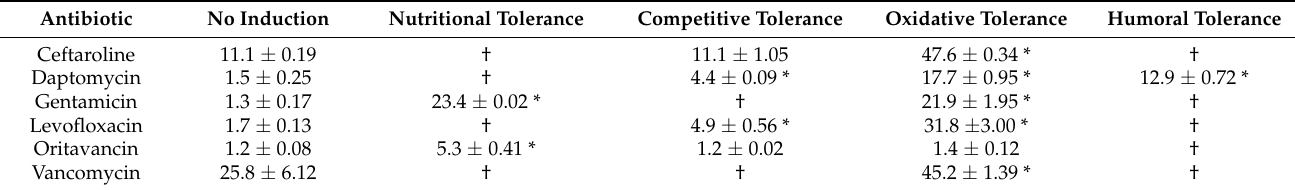
Table 1. Time needed to induce a 3-log reduction in viability (hours).